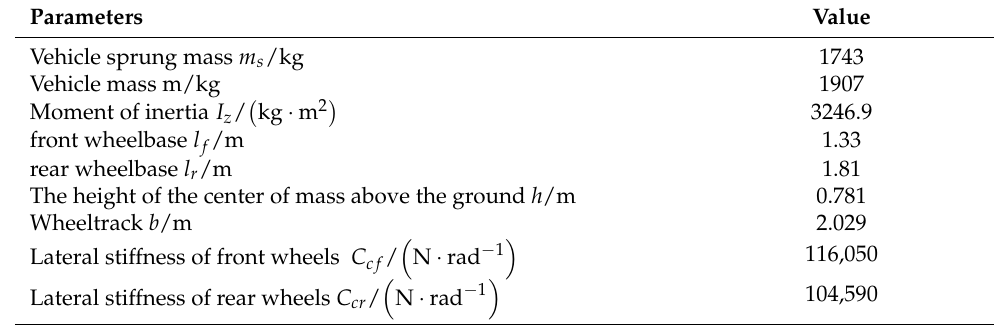
Table 2. The vehicle model parameters.